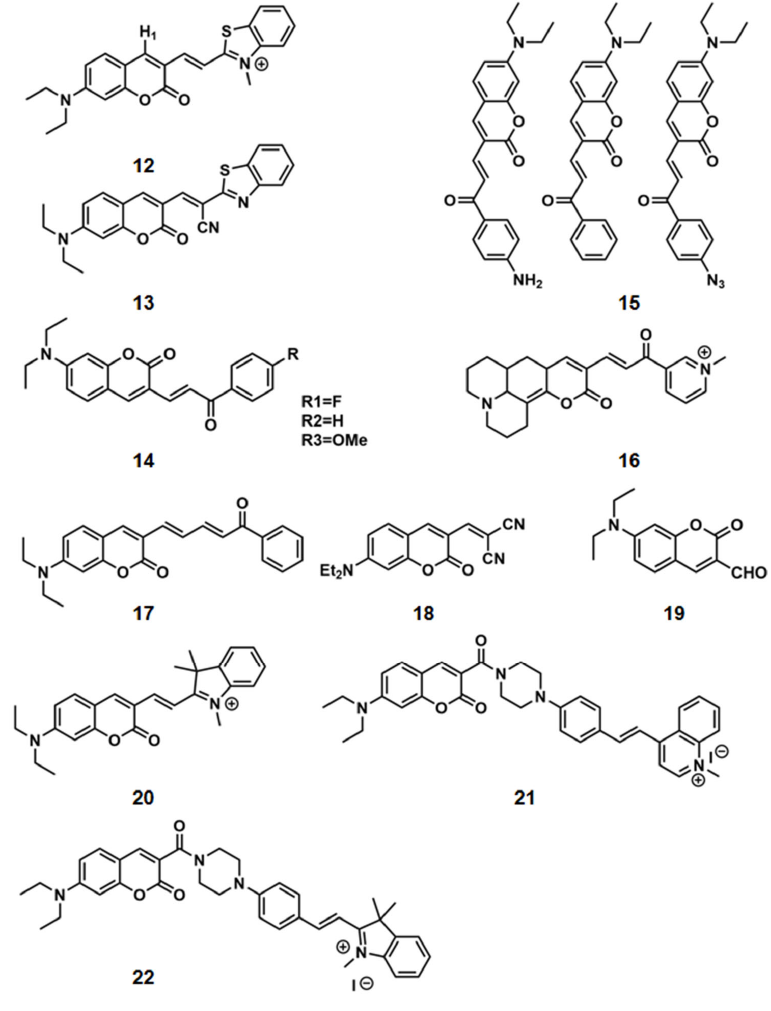
Scheme 5. The fabric of sulfite fluorescent probes 12 − 22 .